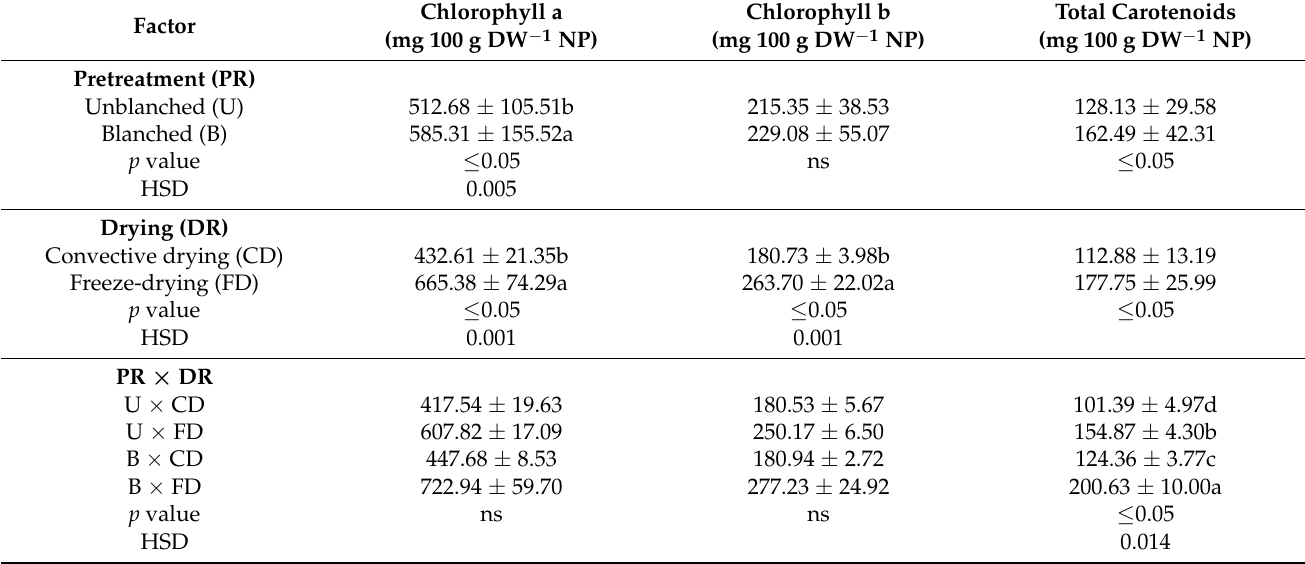
Table 4. The interaction effect of pretreatment (PR) and drying (DR) factors on chlorophylls and total carotenoid content of the nettle powders obtained from different treatments. Data are mean ± standard deviation of the mean. Mean values belonging to the same factor without common letters are statistically different according to HSD ( p ≤